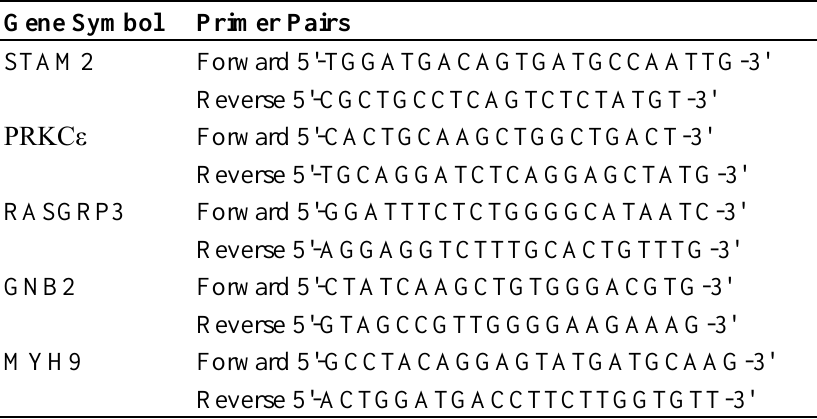
Table 7. Primer sequences used in this